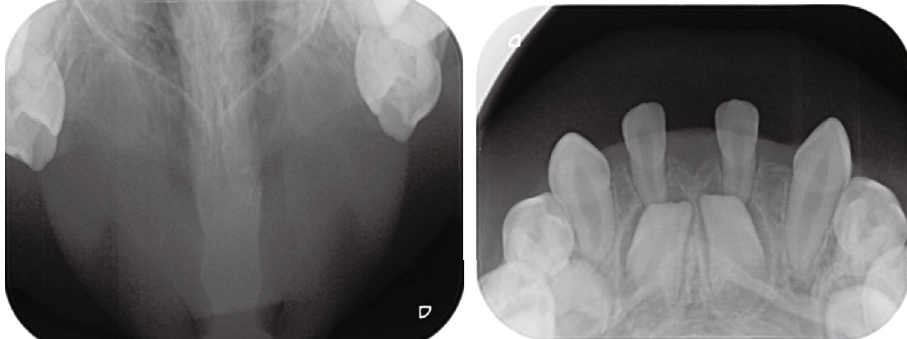
Figure 2: Occlusal view of both the maxillary and the mandibular arches.